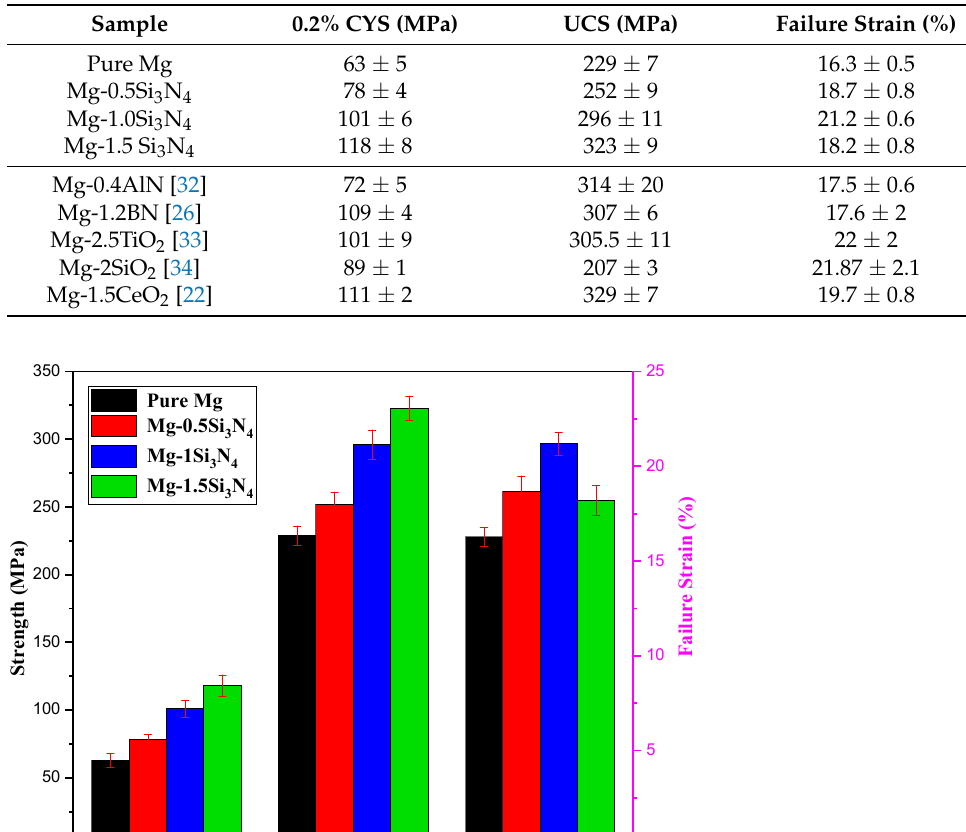
Figure 6. Thermal conductivity of pure Mg and Mg/Si 3 N 4 nanocomposites as a function of ignition temperature. Table 1. Compression test results of the samples.